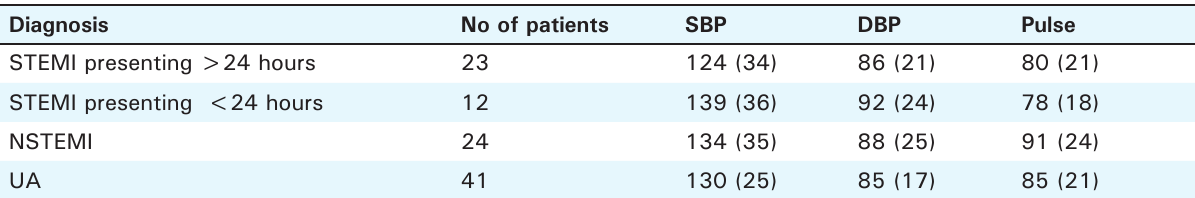
table 2. Distribution of acute coronary syndrome components and their hemodynamic profiles in the patient